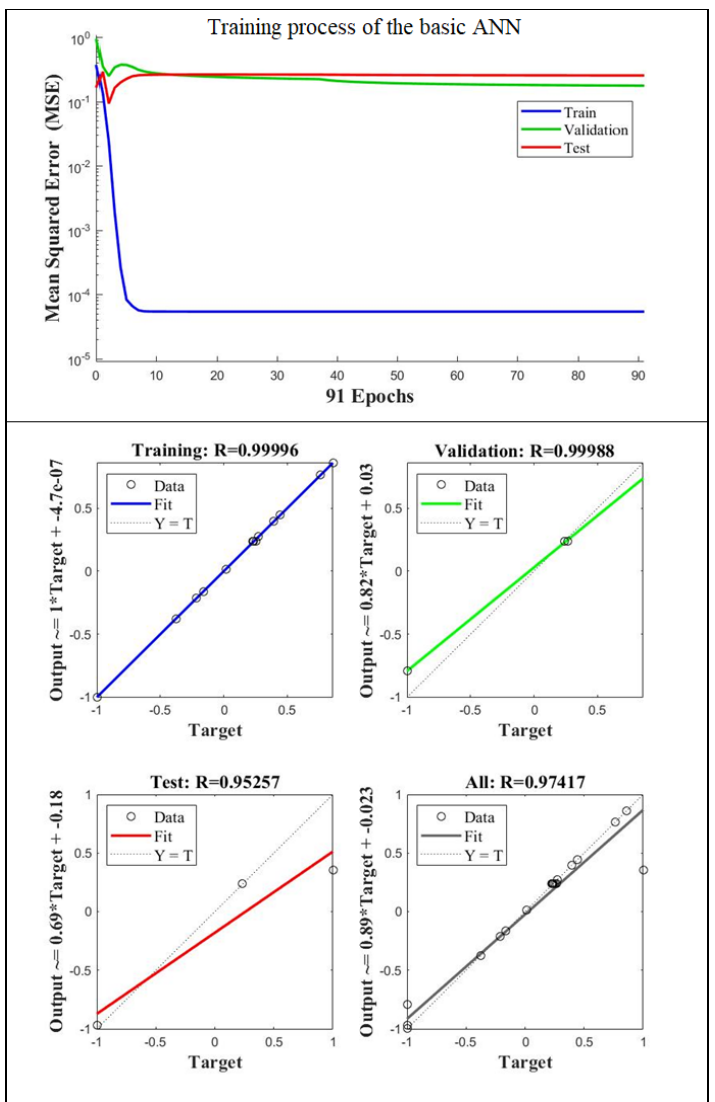
Figure 11. Regression analysis of the basic ANN model.